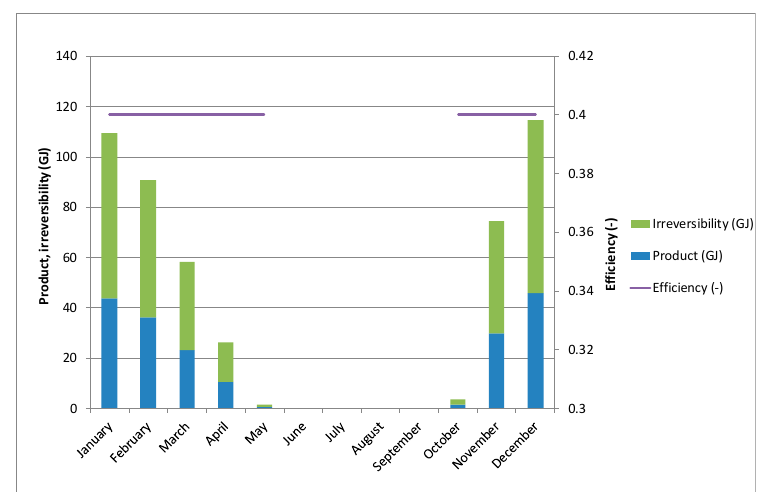
Figure A3. Electric grid: Product, irreversibility and efficiency.